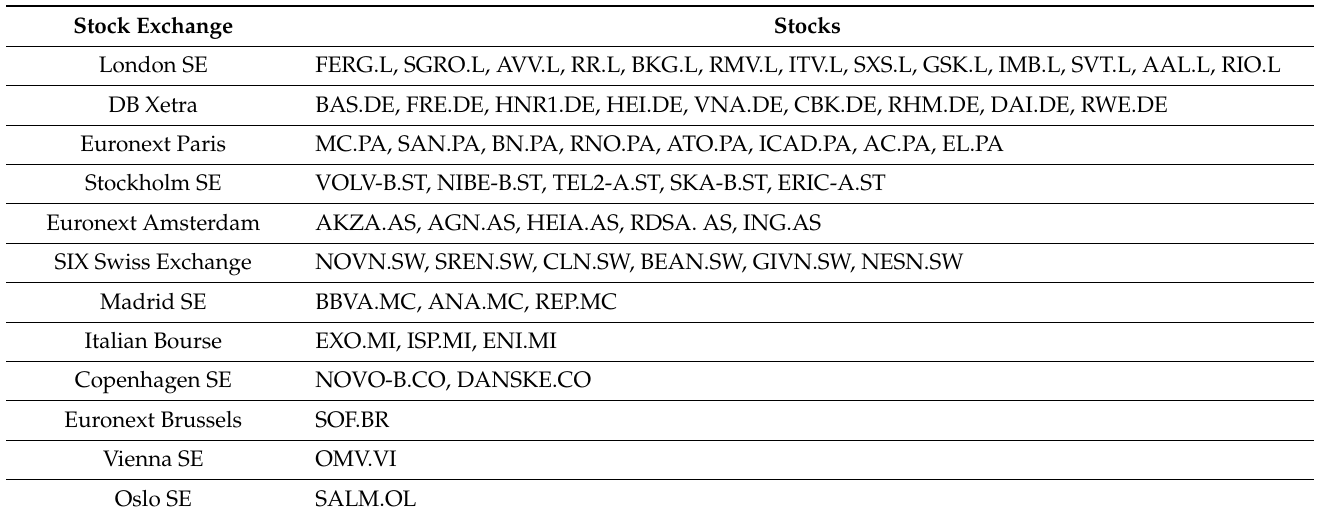
Table 2. List of